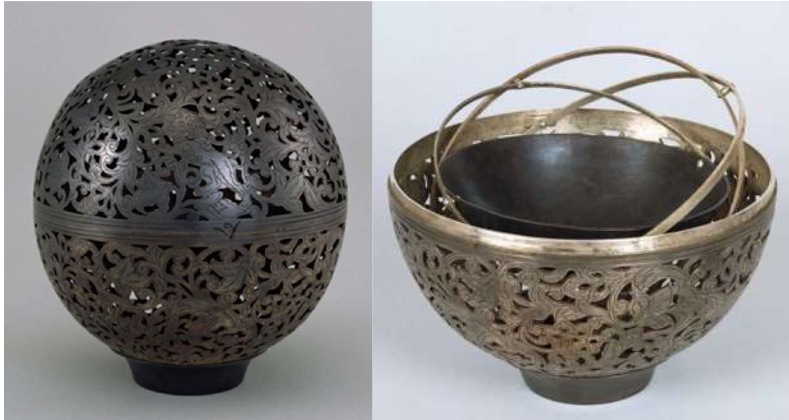
Figure 2. Silver incense burner. Horizontal diameter: 18 cm; vertical diameter: 18.8 cm; weight: 1550 g; upper diameter of foot: 9.6 cm; height of foot: 2.2 cm; overall height: 20 cm. Shōsōin, Tōdai-ji Temple, Nara, Japan.